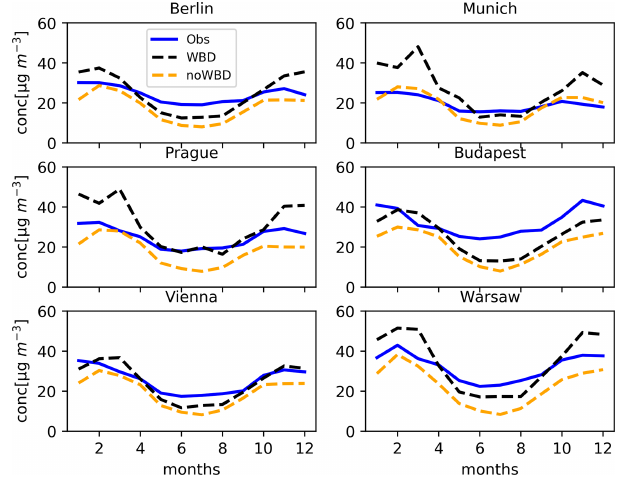
Figure 13. Same as Fig. 12 but for Munich, Budapest and Warsaw.